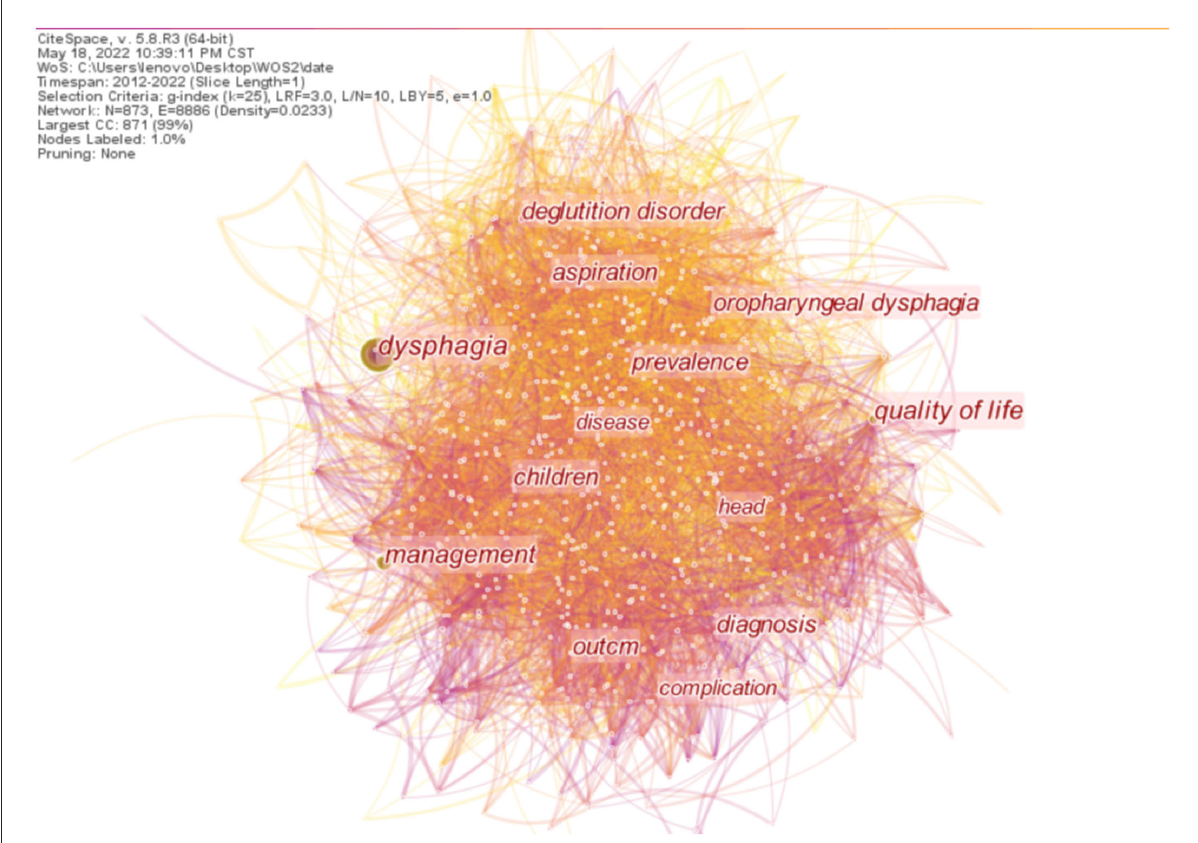
FIGURE9 Map of keyword co-occurrence and cooperative relations on dysphagia from 2012 to 2022. The shorter the distance between the two circles, the more the cooperation between the two keywords.